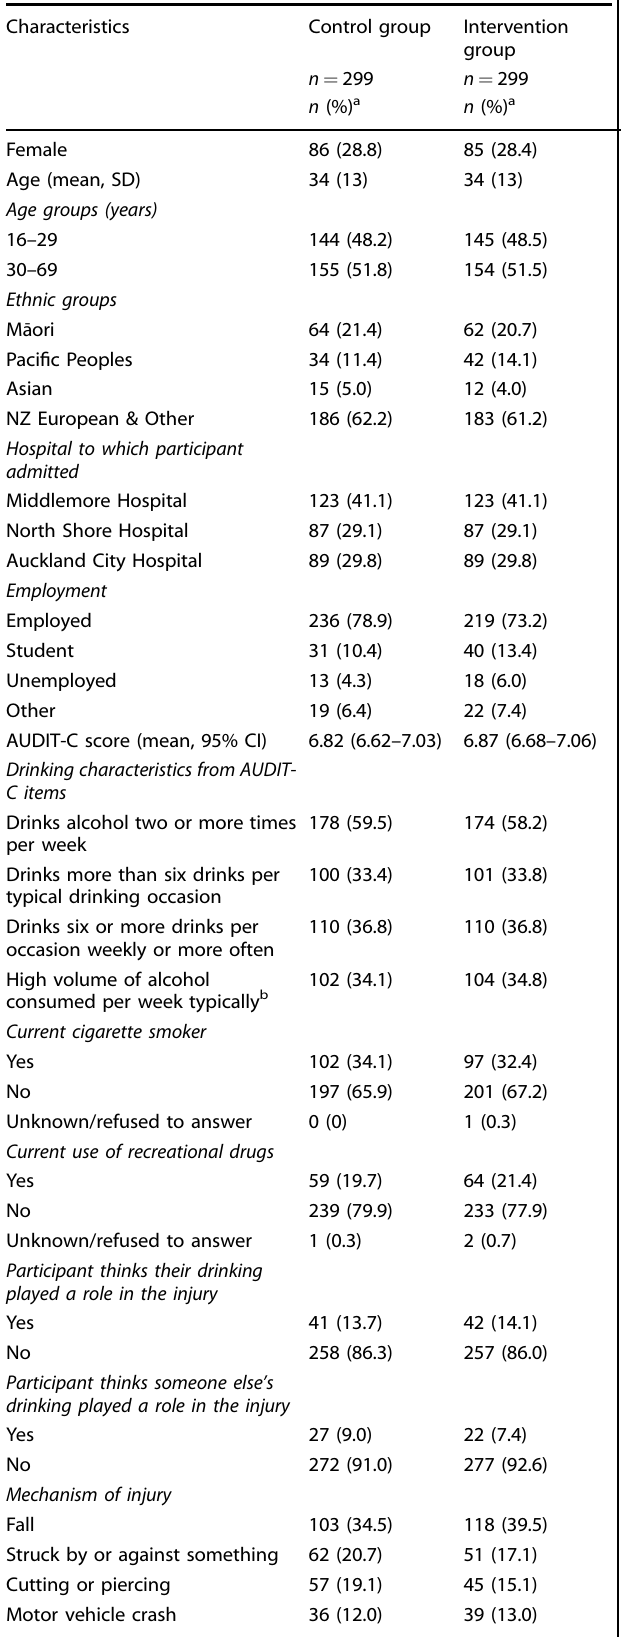
Table 1. Baseline